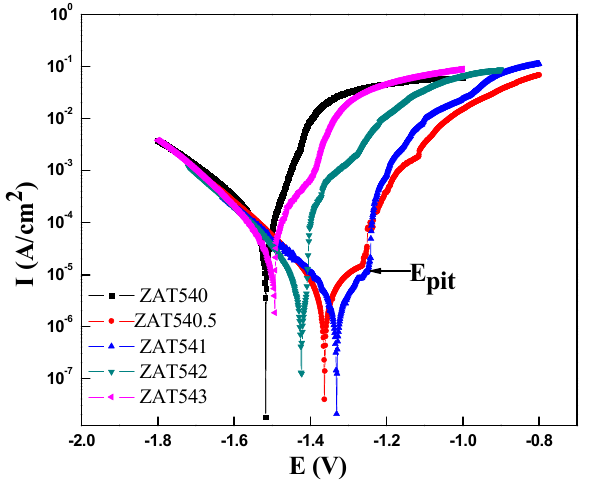
Figure 5. Polarization curves of extruded ZAT54x alloys in 3.5 wt. % NaCl solution at room temperature. Table 3. Potentiodynamic polarization test results of extruded Mg–5Zn–4Al–xSn alloys in 3.5 wt % NaCl solution at room temperature.